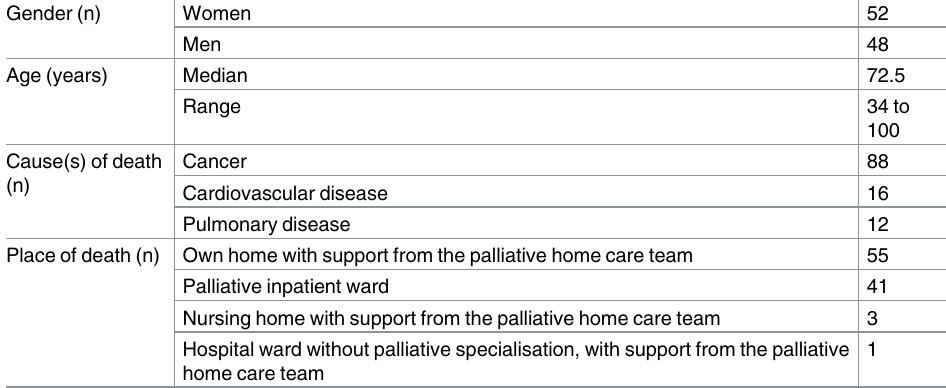
Table 2. Gender, age, place of death and cause(s)of death for the included 100 patients, according to their medical records (some patients had multiple causesof death).